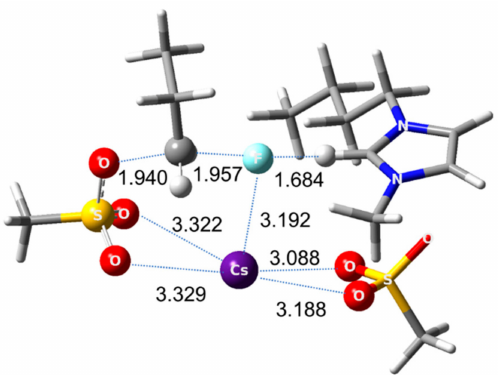
Figure 1. Transition state for S N 2 fluorination using CsF in [bmim][OMs]. MPW1K / 6-311G ** method for C, H, O, N, F, S atoms, Hay-Wadt VDZ ( n + 1) basis set with relevant e ff ective core potential for alkali metal elements Cs, using Gaussian 03 set of